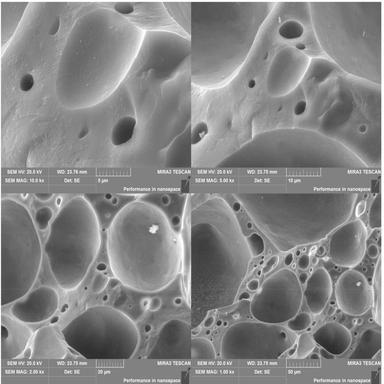
SEM patterns of waste coal cinder.